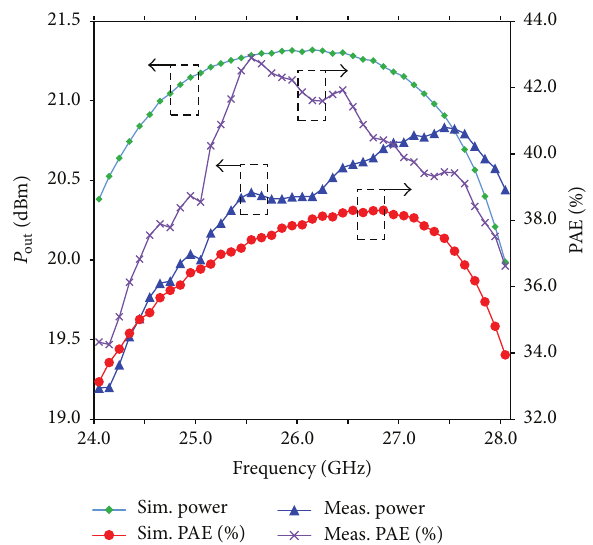
Figure 6: The simulated and measured P-1dB and PAE.